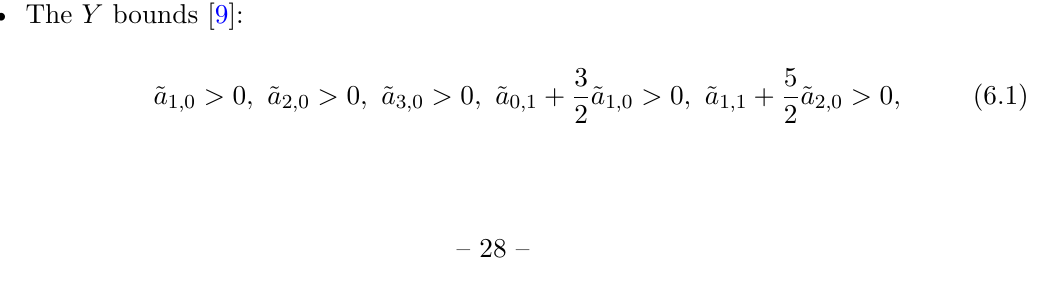
Figure 2 . Positivity bounds on c 3 , 3 / ( ¯ D stu ) bounds with different choices of k . The enclosed region pentagon is the region allowed by 3 , 3 the optimal positivity bounds. Non-optimal positivity bounds are also plotted with equal interval choices of k